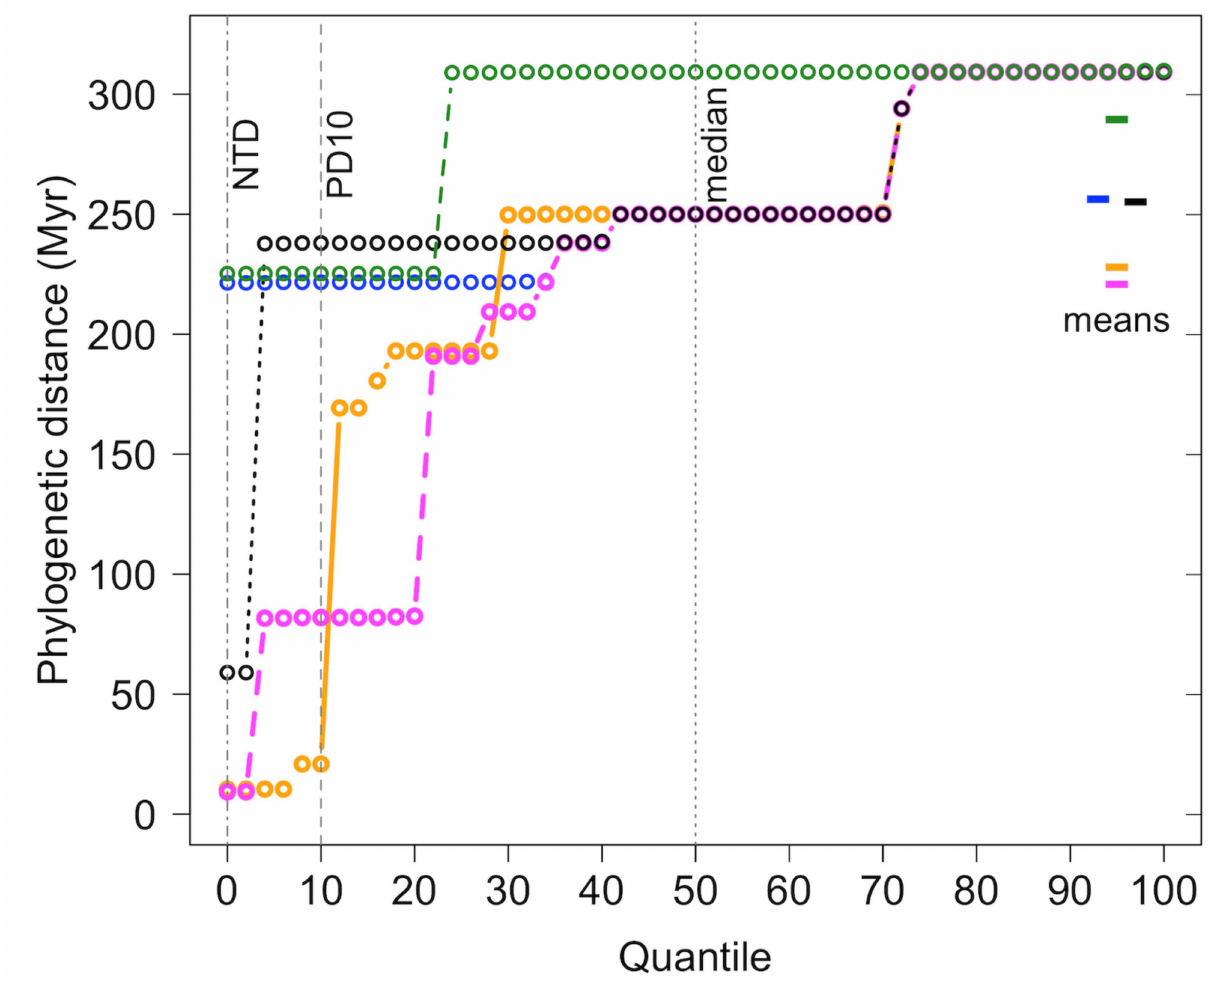
Figure 3. Cumulative phylogenetic distance curves for five focal UCSC Meadow plant species to other species in the community. Phylogenetic distances from the focal species to every other species in the meadow community are based on the phylogenetic tree in Figure 1. Focal species are Medicago polymorpha (orange); Cirsium vulgare (magenta); Rumex salicifolius (black); Anagallis arvensis (blue); Chlorogalum pomeridianum (green). Vertical dashed lines indicate the thresholds for nearest taxon distance (NTD), the 10 th quantile (PD10), the 50 th quantile (median); the mean phylogenetic distance for each focal species is shown as a correspondingly colored bar at